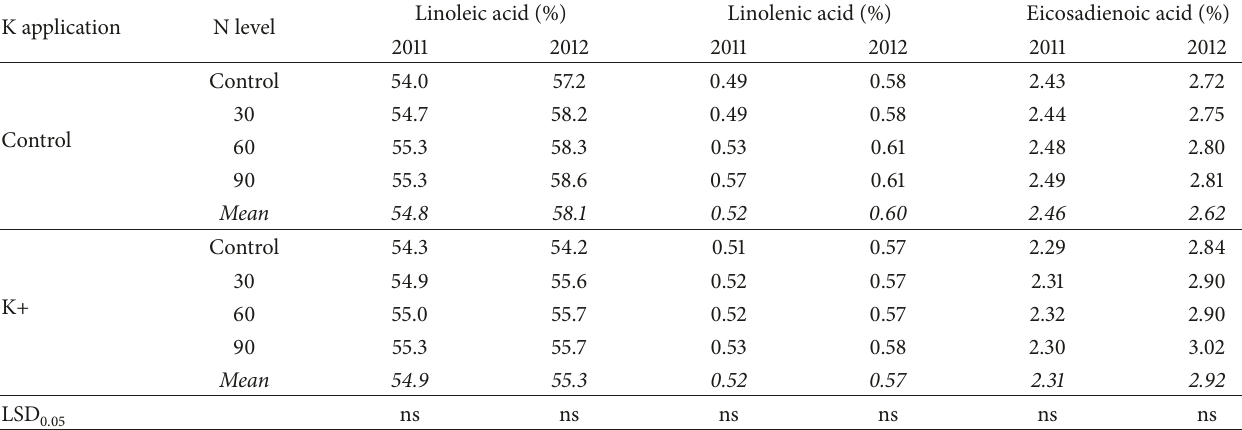
Table 6: Effects of N doses and K application on linoleic, linolenic, and eicosadienoic acid of black cumin in 2011 and 2012. K